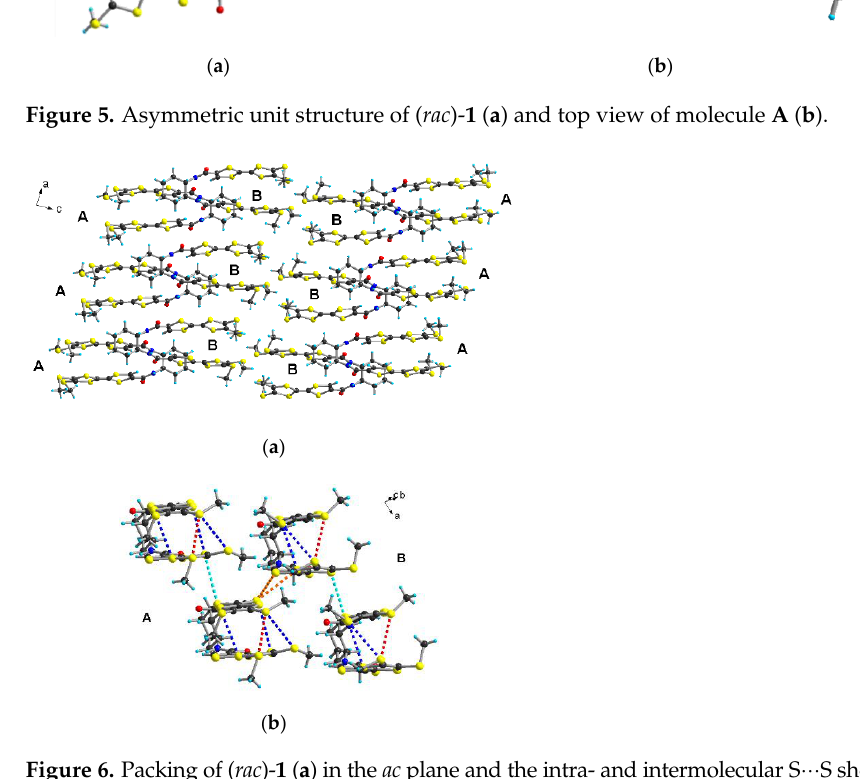
( b ) Figure 8. View of crystals ( a ) and the partial structure of ( rac )- 1 in the radical cation salt with AsF 6 ⁻ ( b ). The anions were omitted due to insufficient crystallographic data. Resistivity measurements were performed on single crystals of the radical cation salt of ( rac )- 1 and AsF 6 – , and the results are presented in Figure 9. The temperature depend- ence of the electrical resistivity indicates a semiconducting behavior of this radical cation